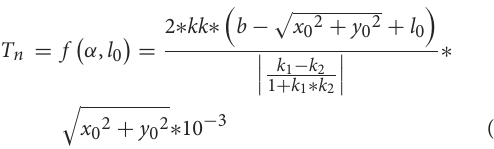
FIGURE5 Relationship between joint torque and deformation